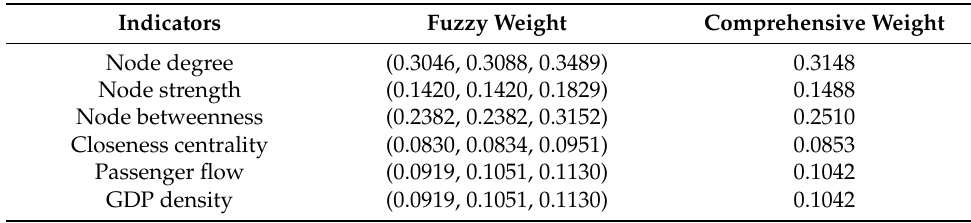
Table 5. The relative importance coefficient of the